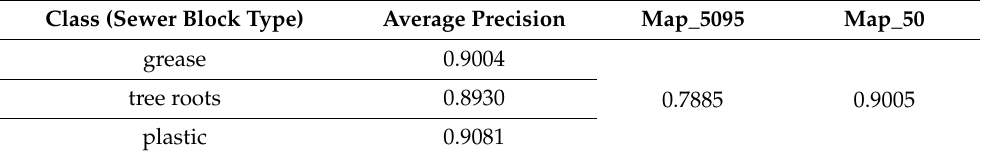
Table 8. Precision results of the trained model.